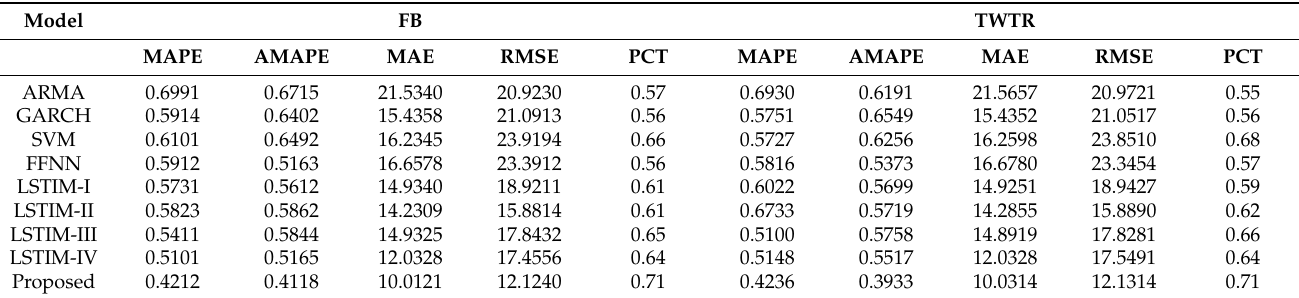
Table 4. Prediction performance for 75 days: FB and TWTR.